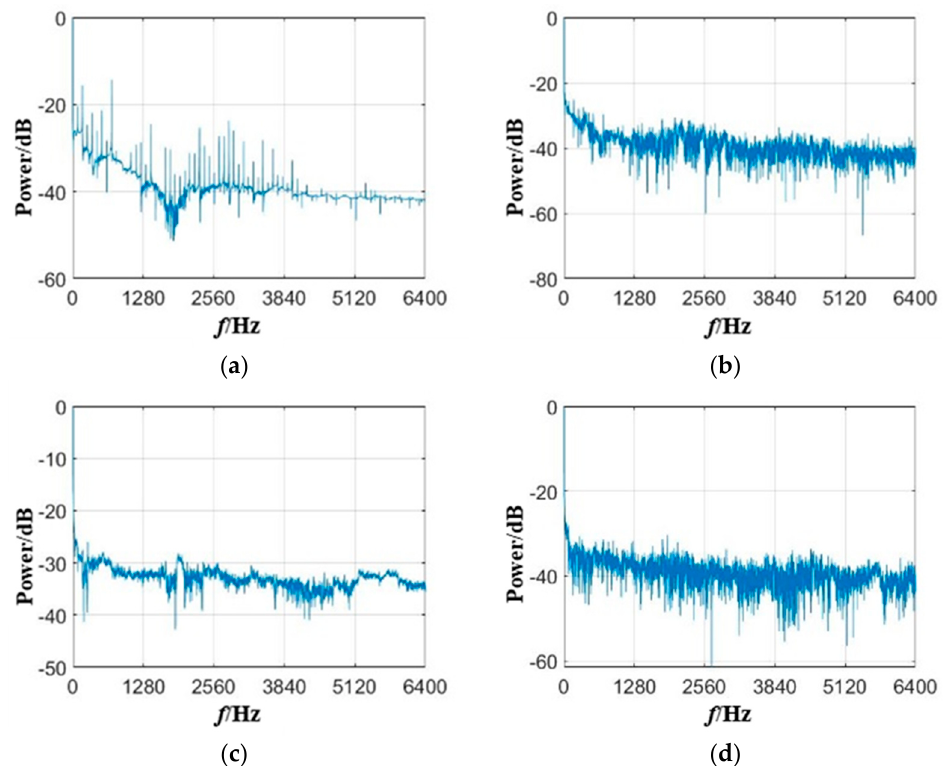
Figure 6. Power spectrum in X-direction of the pump inlet pipe. ( a ) normal operation. ( b ) incipient cavitation. ( c ) cavitation. ( d ) severe cavitation.